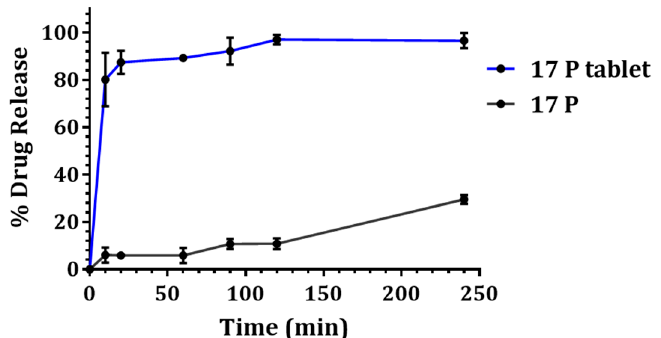
Figure 3. In vitro drug release of 17P tablet and API in 500 mL simulated vaginal fluid (SVF) + 0.5% w / v Tween 80. Within 10 min 17P release from the tablet was found to be around 80%, whereas the release from API was only 5%. 17P tablet helped maintain the drug in a supersaturated state up to 4 h.